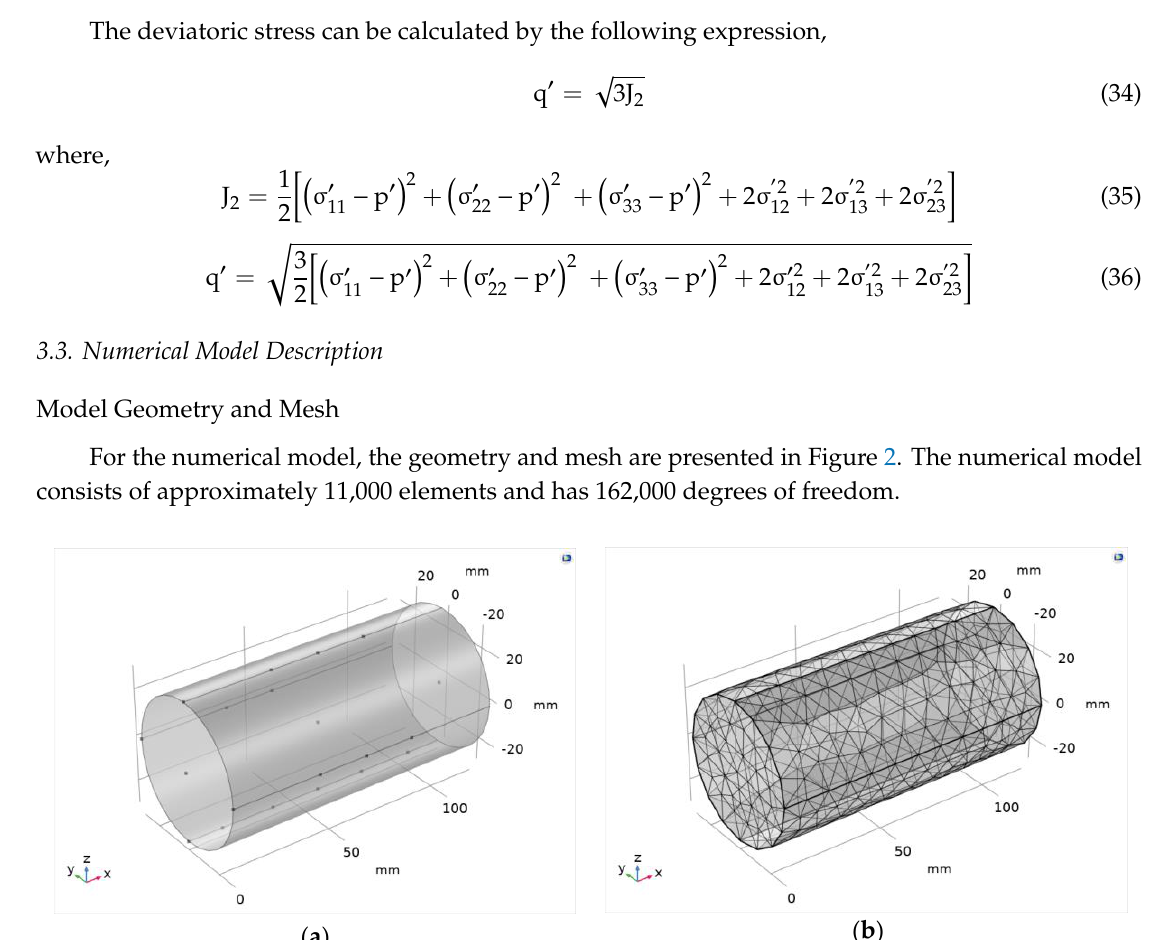
Table 1. Verification study parameters.